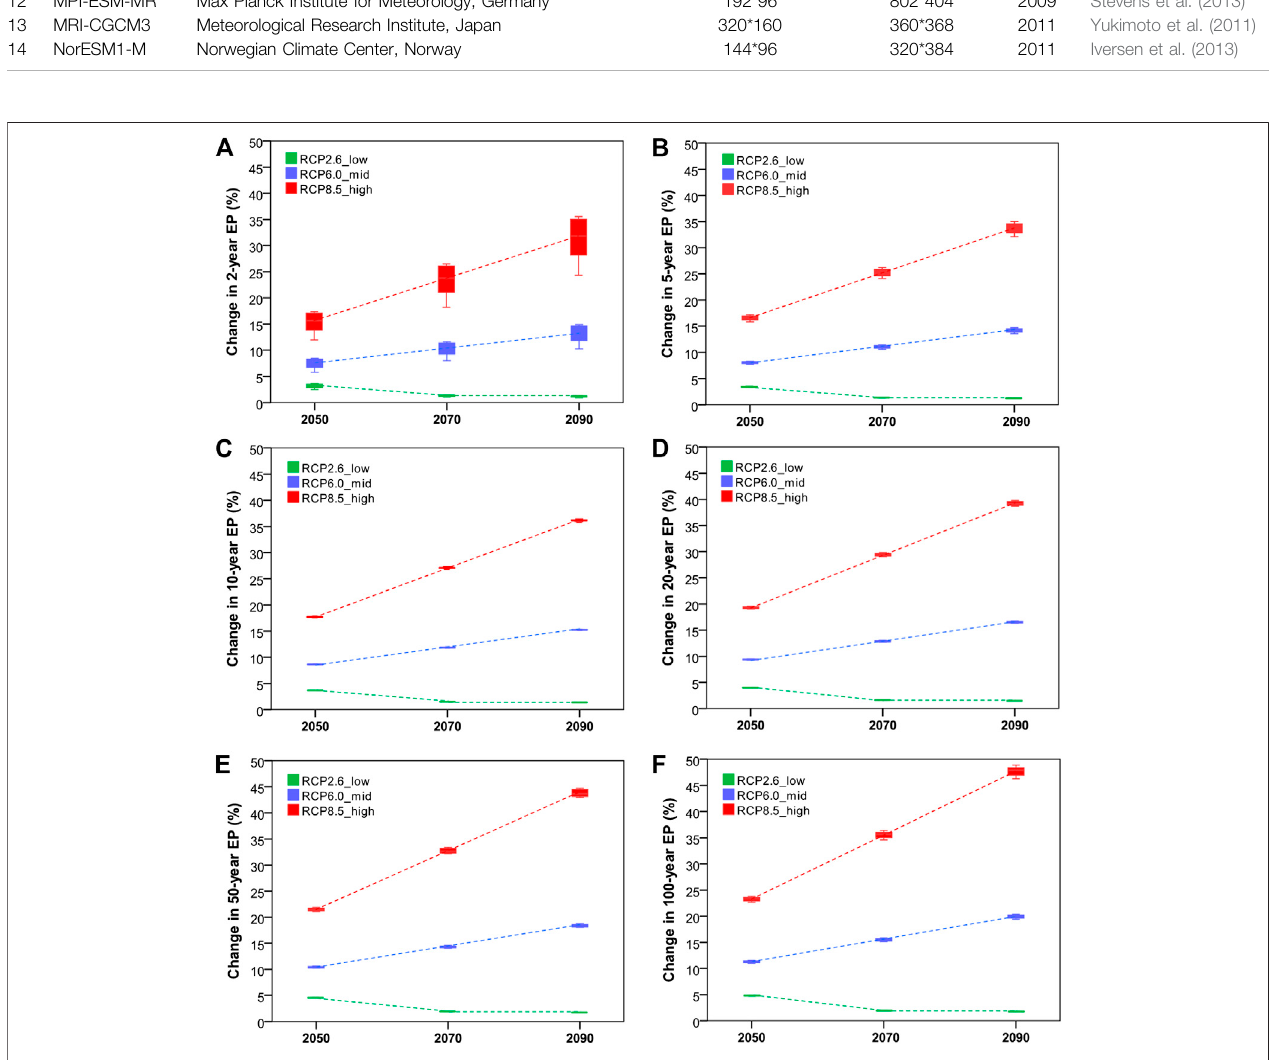
FIGURE2| Spatialvariabilityofchangeinfuture5-dayextremeprecipitationundertheensemblescenariocorrespondingtodifferentreturnperiods:T (cid:2) 2 years (A) , T (cid:2) 5 years (B) , T (cid:2) 10 years (C) , T (cid:2) 20 years (D) , T (cid:2) 50 years (E) , and T (cid:2) 100 years (F) . Figure presents data of 20 stations.